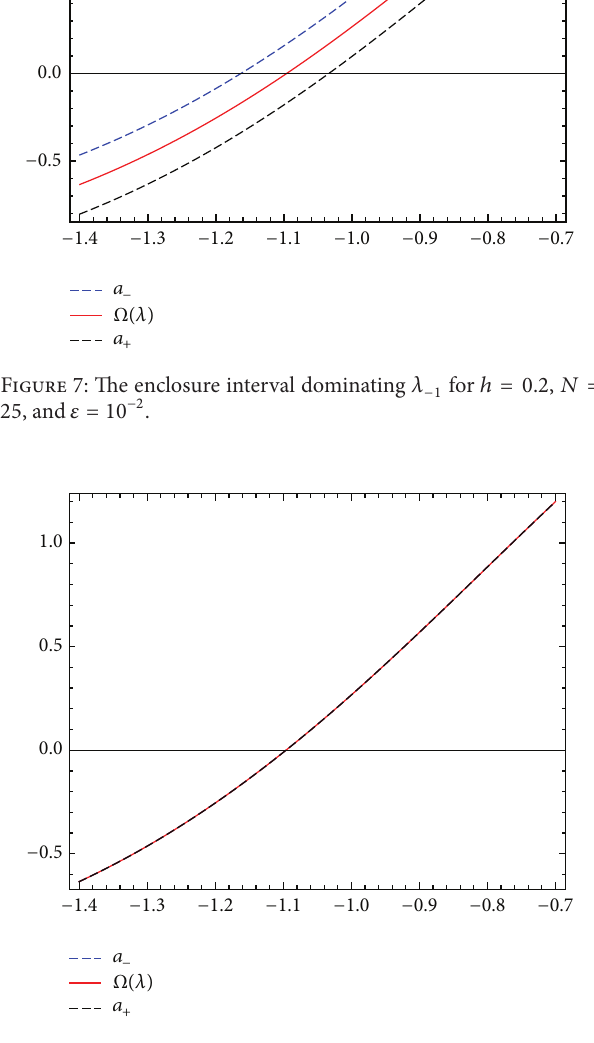
Figure 8: The enclosure interval dominating 𝜆 −1 for ℎ = 0.2 , 𝑁 = 25 , and 𝜀 = 10 −5